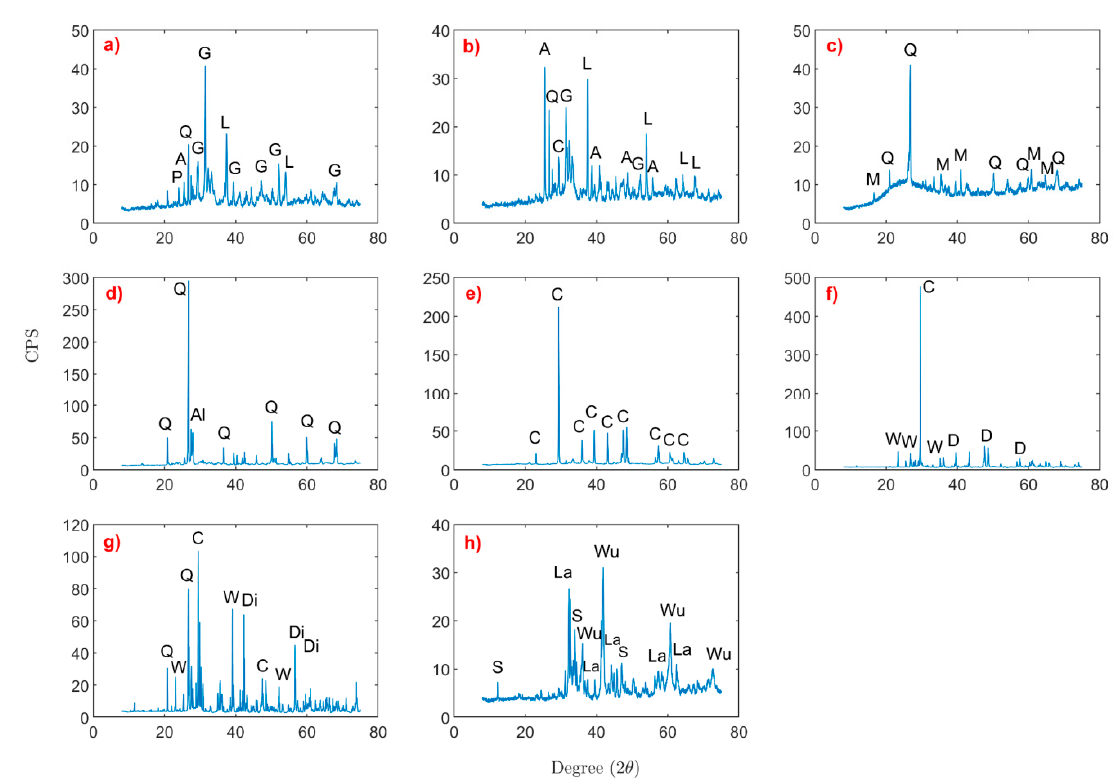
Figure 3. XRD patterns of the samples, a : biomass fly ash (FA1) 1, b : biomass fly ash 2 (FA2), c : coal fly ash (FA3), d : bottom ash (BA), e : green liquor dregs (GLD), f : fine limestone tailings (MTF), g : coarse limestone tailings (MT), h : steel slag (SS);